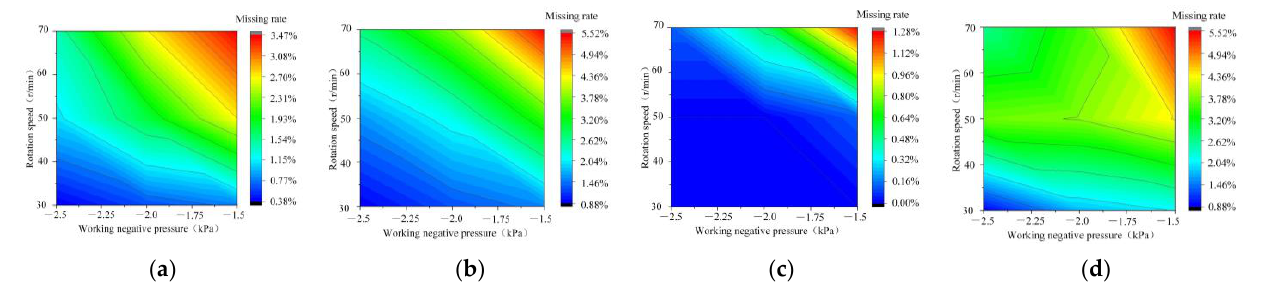
Figure 16. Contour map of the leakage rate of seed filling in different-shaped suction holes. ( a ) Cylindrical-shaped suction hole; ( b ) Funnel-shaped suction hole; ( c ) Horn-shaped suction hole; ( d ) Diabolo-shaped suction hole.